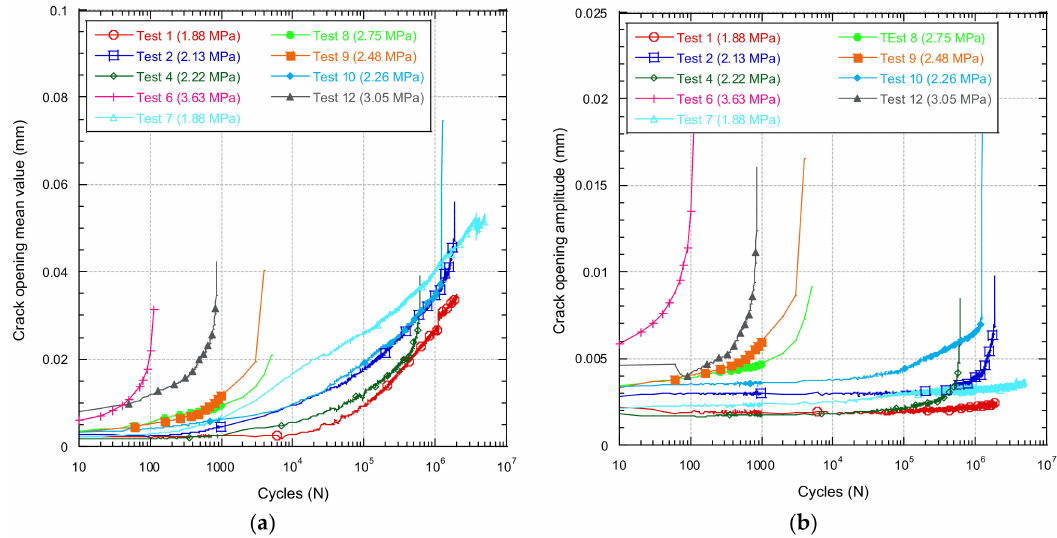
Figure 15. Evolution of the mean crack opening value ( a ) and amplitude ( b ) as a function of the number of cycles. Increasing the stress range value increases the growth rate of the maximum opening value, the average value, and the amplitude. Based on the analysis of the evolution of the growth of the notches throughout the test, it could be deduced that, in the case that